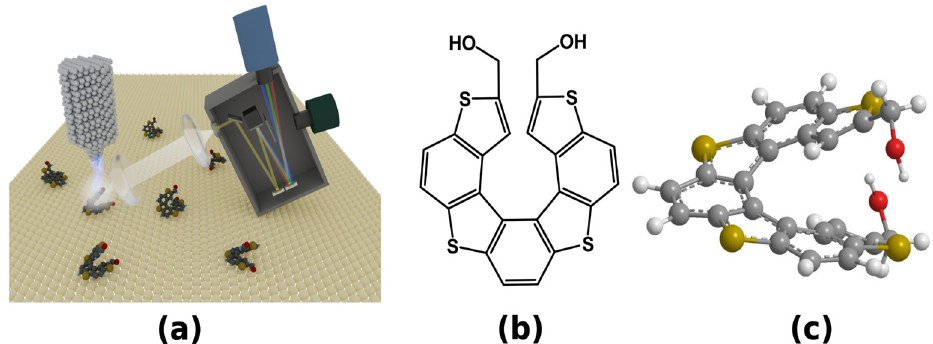
Figure 1. ( a ) Schematic illustration of STM-LE equipment. Local light emission induced in tunneling junction on molecule/substrate system is collected through lens and transmitted to photodetectors. ( b ) Molecular structure of 2,13-bis(hydroxymethyl)[7]-thiaheterohelicene and ( c ) its three-dimensional view of M-type enantiomer ((M)-[7]TH-diol). The red, gray, white, and yellow balls indicate O, C, H, and S atoms, respectively.